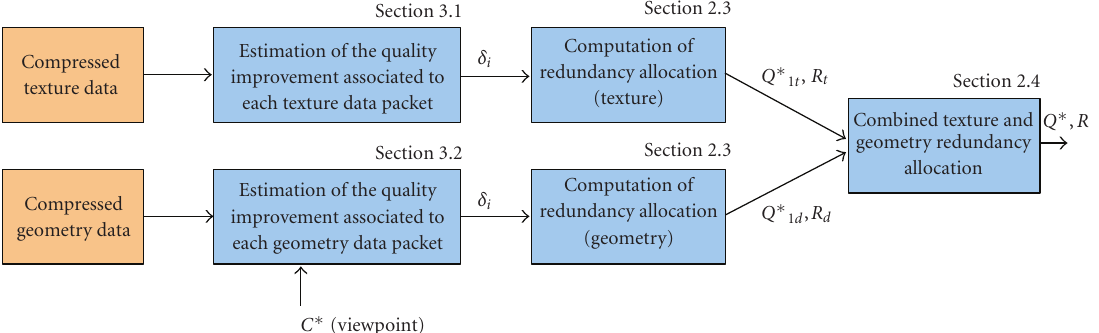
Figure 1: Block diagram of the proposed redundancy allocation scheme. The numbers over the blue boxes indicate the corresponding section in the